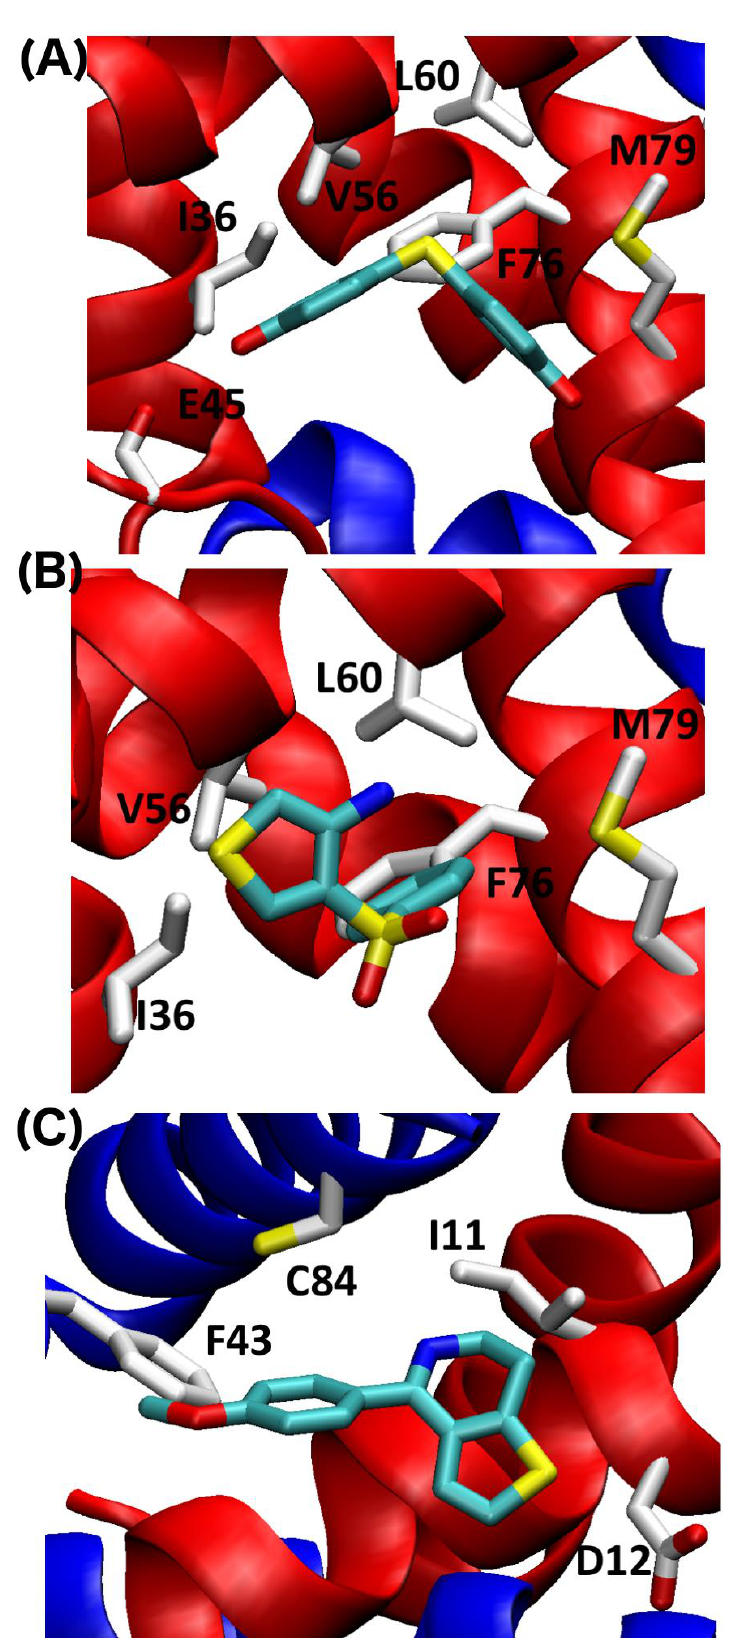
Figure 8. Predicted binding mode of ( A ) BTB10184 ( B ) KM01765 and ( C ) SEW01483 for Ca 2+ -S100B. Residues at the pocket are labeled. For ( C ), interface residues are colored by the chain color.